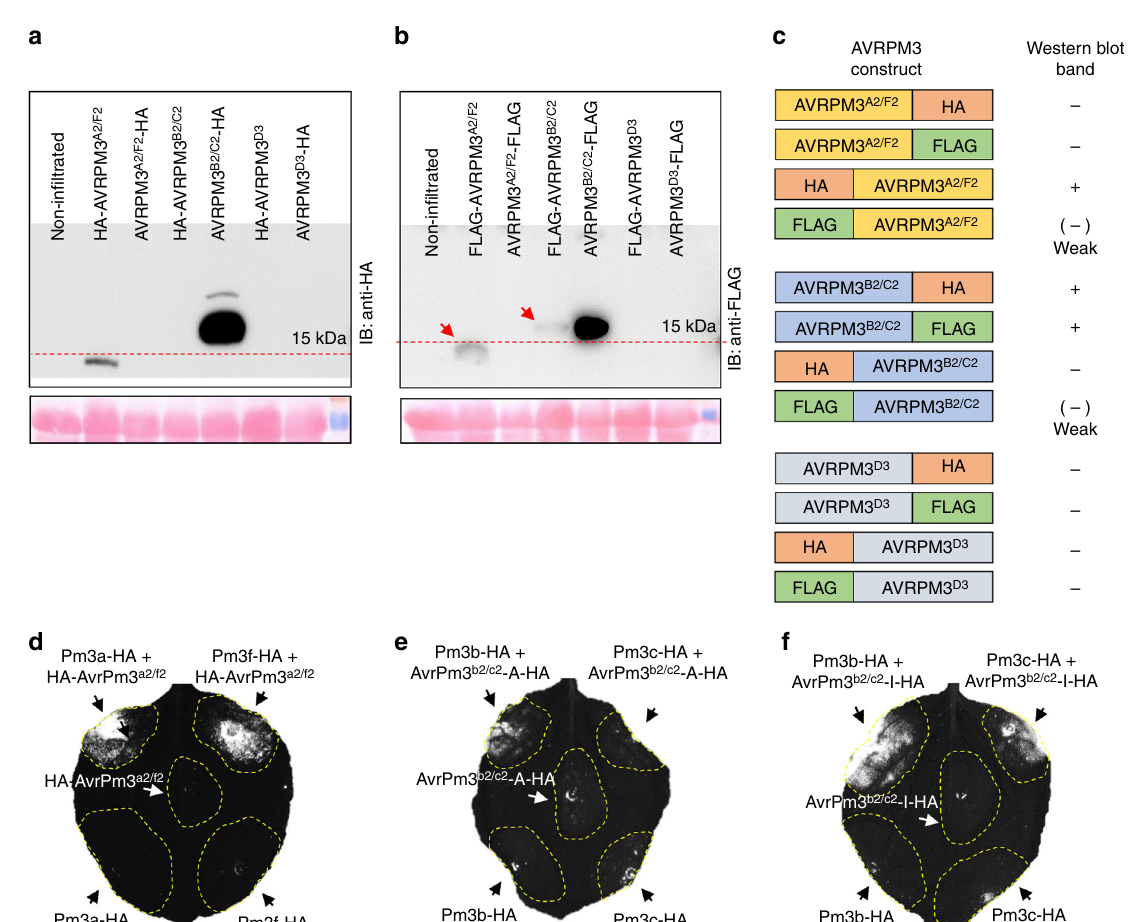
Fig. 2 Impact of epitope fusion of the AVRPM3 protein expression and detectability. a , b Western blot detection of C and N terminal HA ( a ) and FLAG ( b ) epitope tag fusion of AVRPM3 A2/F2 , AVRPM3 B2/C2 and AVRPM3 D3 (upper panel) and Ponceau staining of the Western blot membrane (lower panel) are depicted. Uncropped western blot images are provided in a Source Data File. c Graphical summary of AVRPM3 protein tagability based on detection of the protein on a western blot, demonstrating signi fi cantly different impacts of epitope fusions based on tag position and sequence. d – f experimental assessment of HA tagged AVR variants in functional validation assays in N. benthamiana . Protein expression data is provided in Supplementary Fig. 6. HA- AVRPM3 A2/F2 ( d ), AVRPM3 B2/C2 -A-HA ( e ) and AVRPM3 B2/C2 -I-HA ( f ), co-expressed with their respective NLRs. HR was assessed using HSR imaging 4 – 5 days after Agrobacterium in fi ltration. Results are consistent over at least two independent assays each consisting of 6 – 8 independent leaf between HA-SVRPM3 A1/F1 , and HA-svrPM3 A1/F1 (Fig. 3e), and